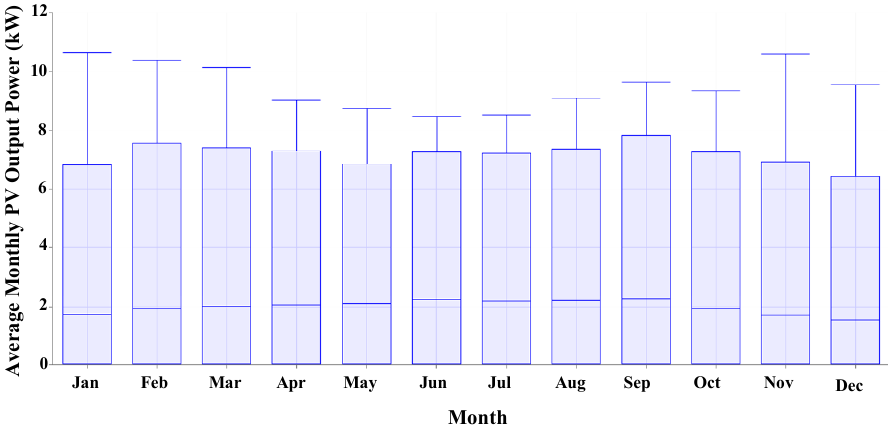
Figure 11. Average monthly PV system output power. Table 3. Grid emission productions over the optimization year.